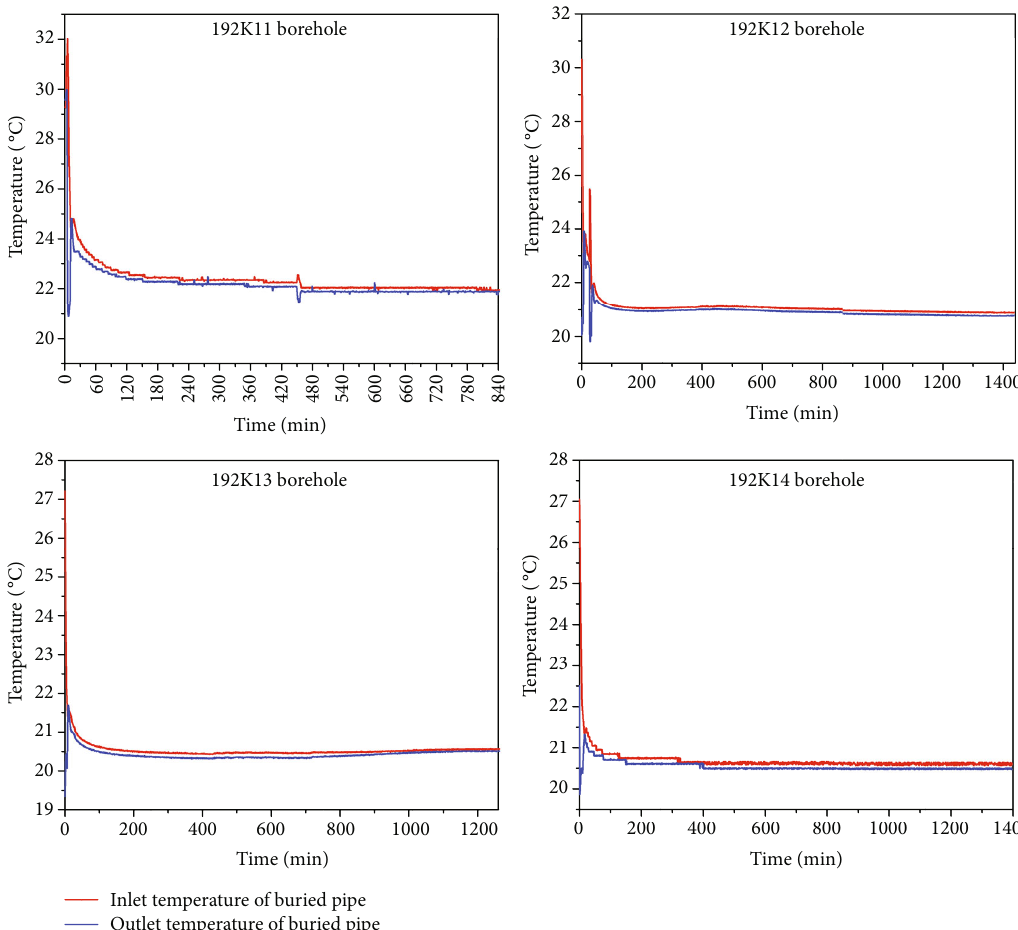
Figure 7: Initial average temperature of the rock-soil body in 4 geothermal test